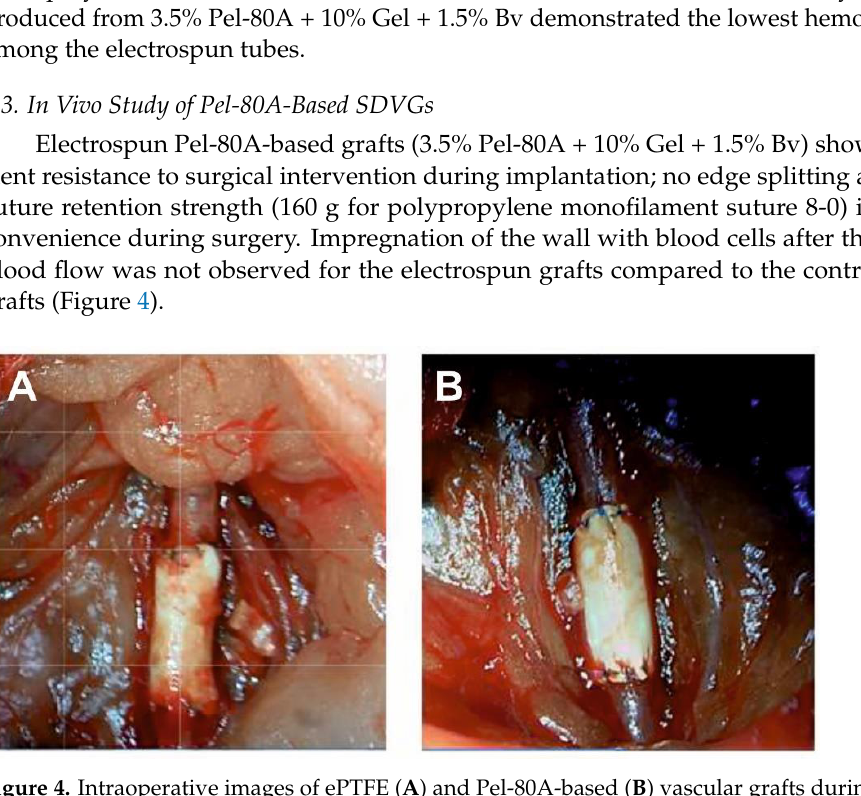
Figure 4. Intraoperative images of ePTFE ( A ) and Pel-80A-based ( B ) vascular grafts during surgical implantation in rats.